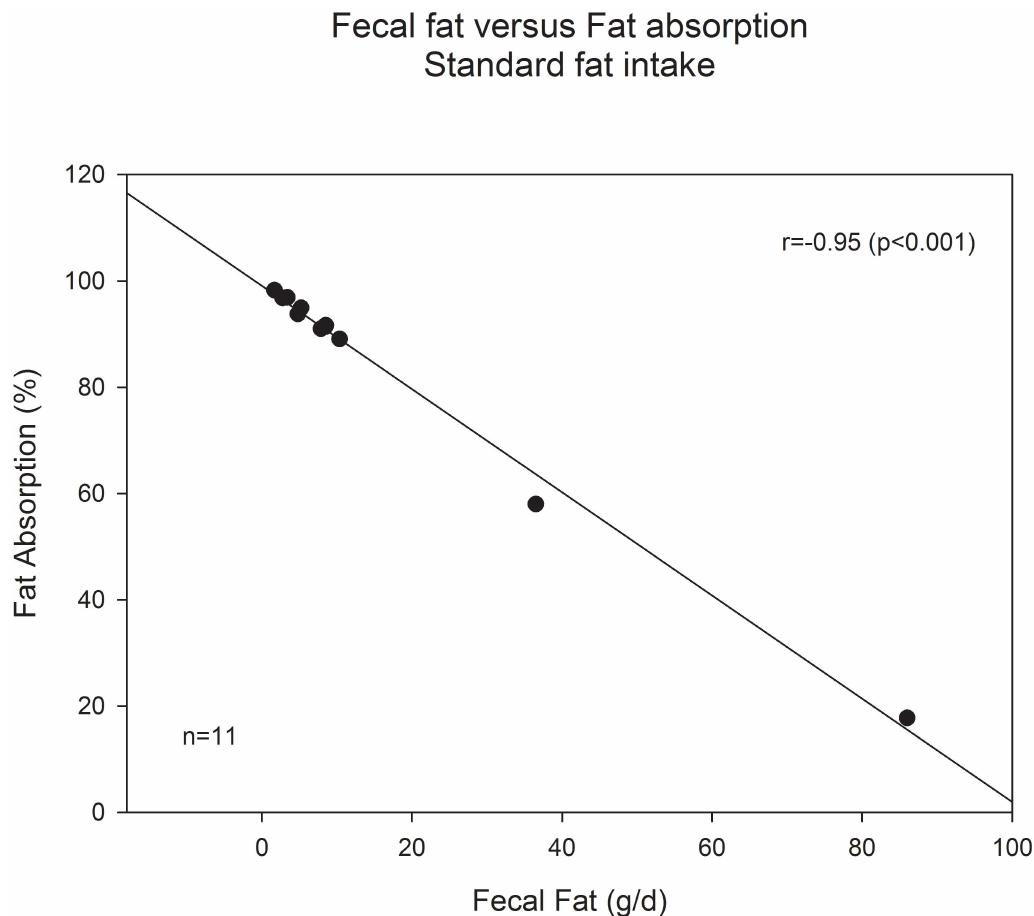
Fig 3. Correlation of fecal fat (g/d) vs fat absorption (%) in relation to fat intake (g/d). Recommended range of fat intake (80–120g/d). Absolutefat values in stool correlate well to the more complex, intake adjusted fat absorption